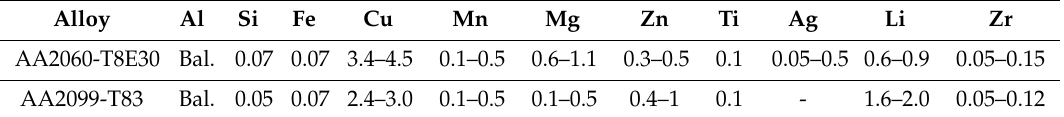
Table 1. Chemical compositions of base materials,